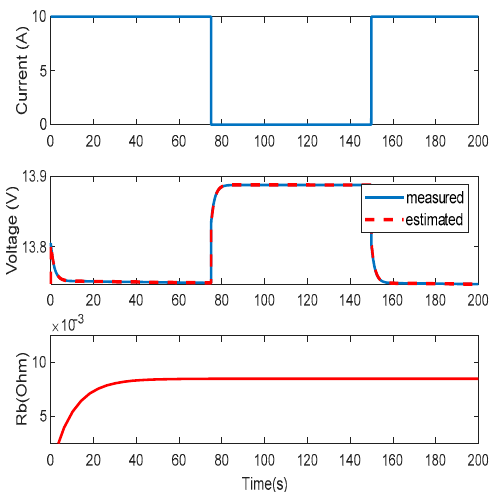
Figure 5. Battery SOH estimation with an aged LiFePo4 battery (simulation).